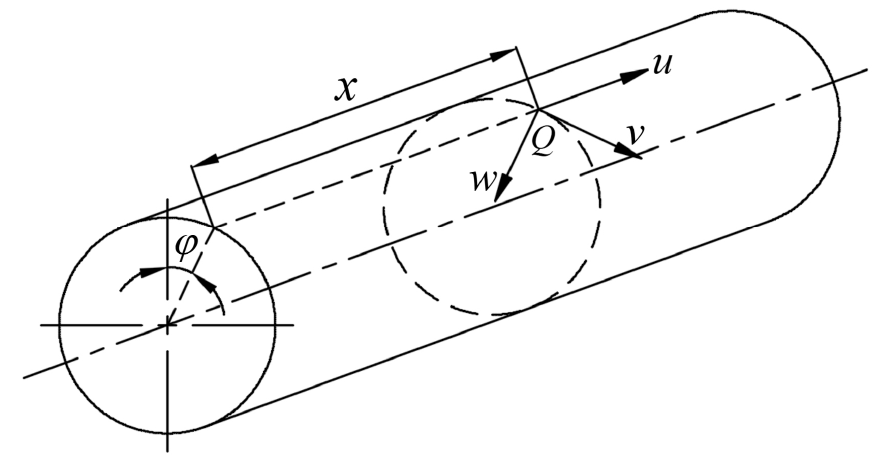
Figure 2. Cylindrical coordinates system definition.